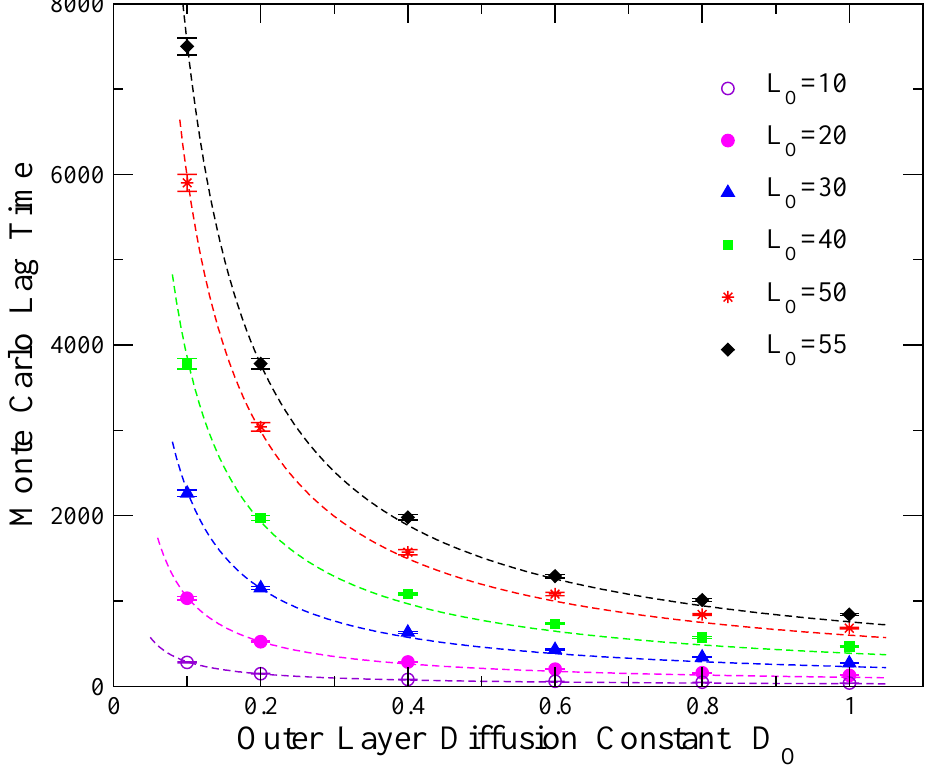
of the outer layer. O , for different O